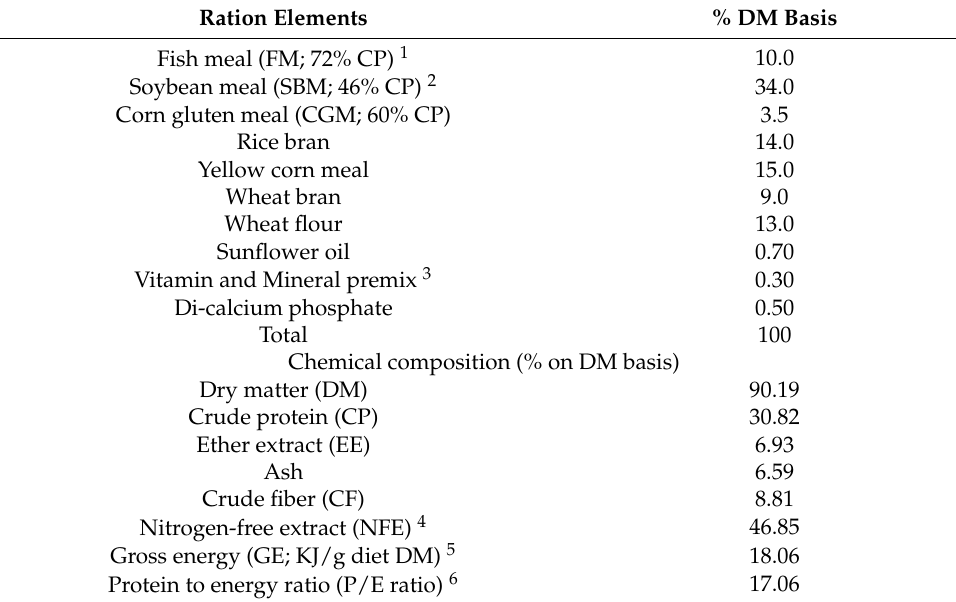
Table 1. Ration elements, nutrients, and chemical composition (% on dry matter (DM) basis) of the reference